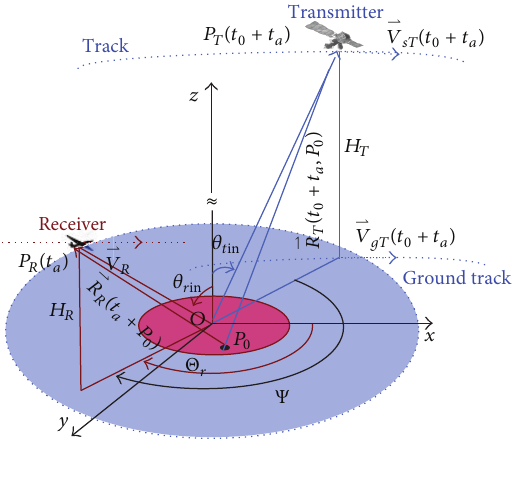
Figure 4: GEO-UAV BiSAR geometry.